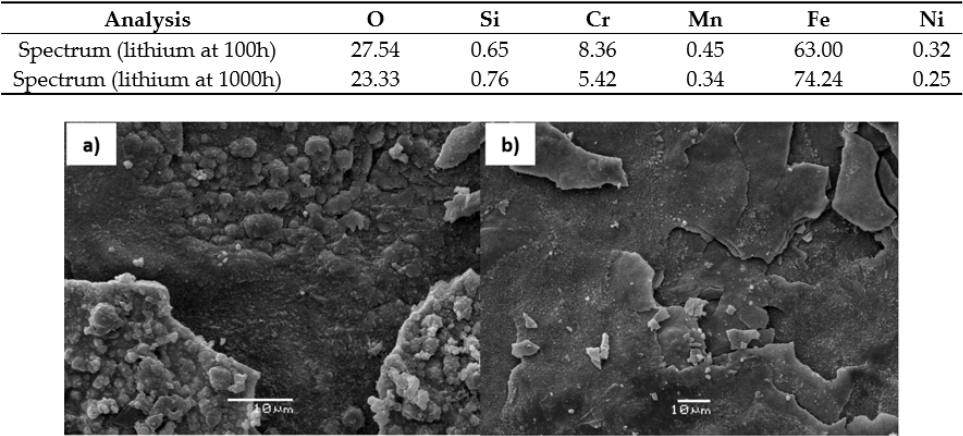
Figure 21. Surface of VM12 stainless steel in Lithium Salt LiNaKNO 3 at ( a ) 100 h ( b ) 1000 h, at 550 °C.